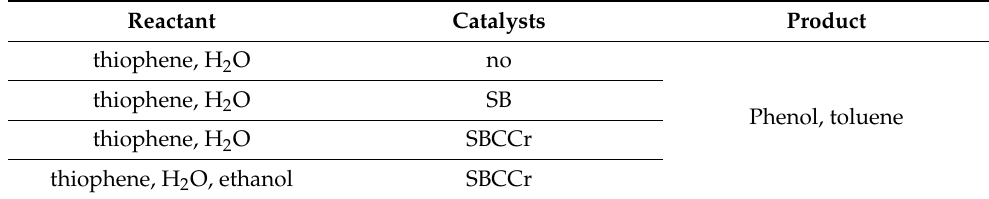
Table 6. The new compounds of thiophene under different reaction